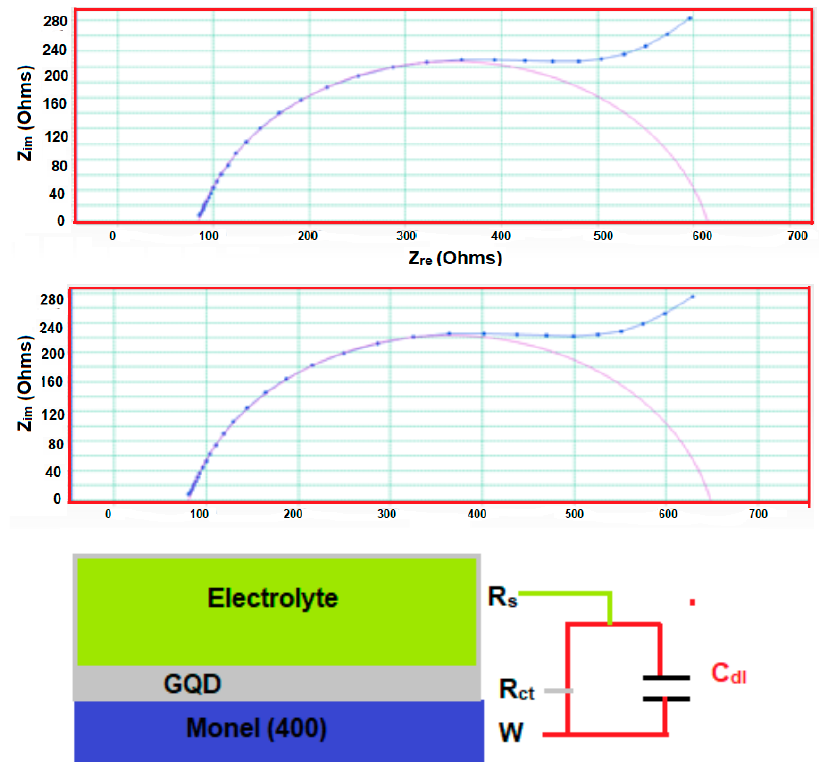
Figure 6. Nyquist plot for the Monel coated with Graphene quantum dots (GQD). Upper curve represents first run and bottom curve represents after Tafel polarization. Equivalent circuit is given at the bottom.